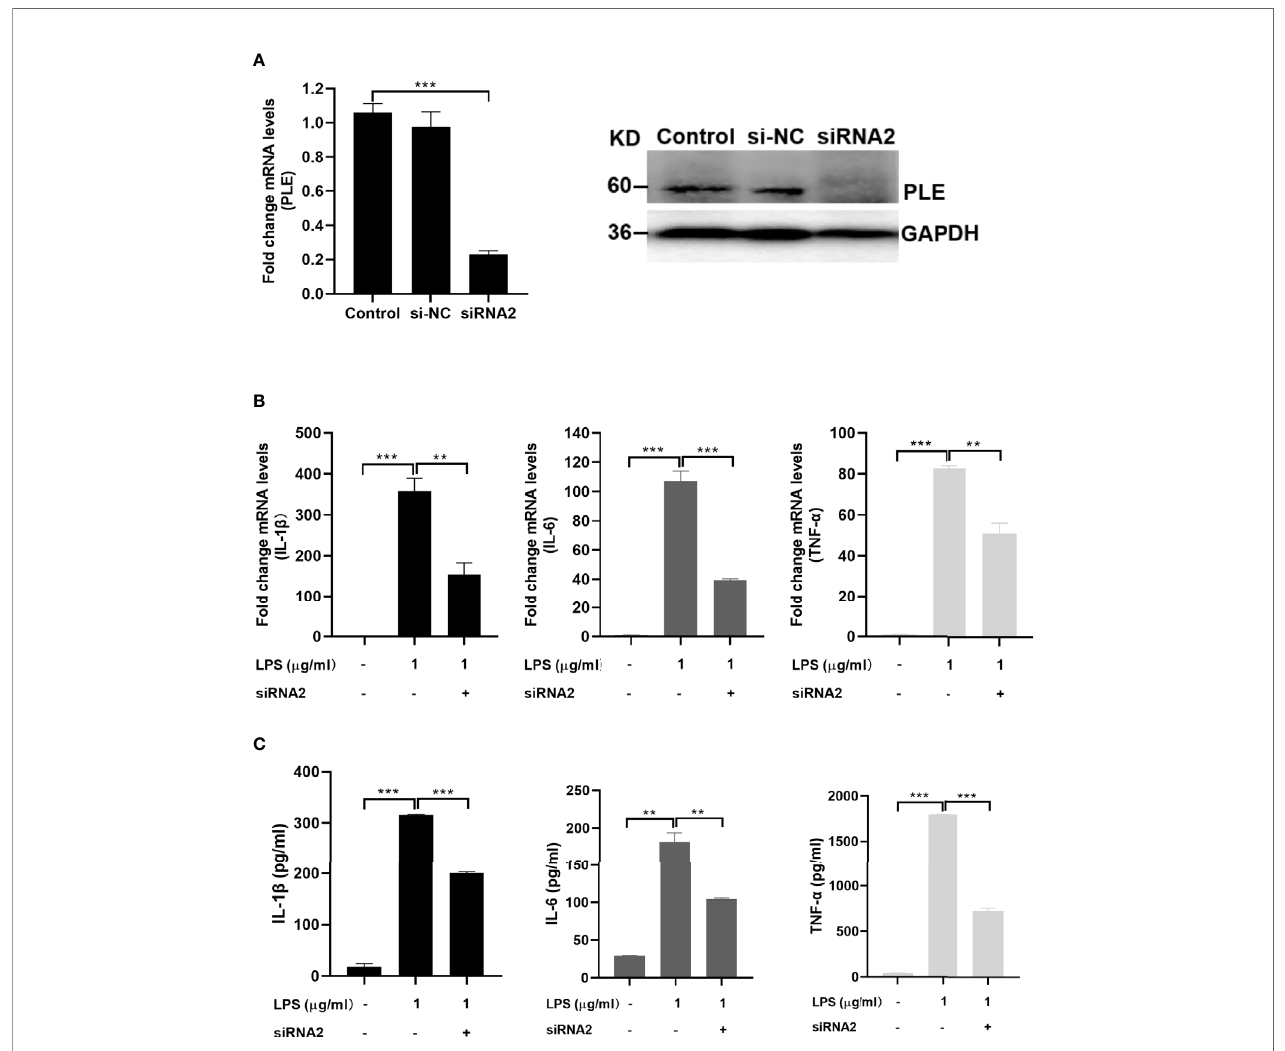
FIGURE 5 | Decreased LPS-stimulation on the expression of proin fl ammatory cytokines in PAMs by transfection of siRNA2 targeting PLEs. (A) The expression of PLEs was con fi rmed by RT-qPCR (left) and western blotting (Right). si-NC: si negative control. (B) Decreased LPS-stimulation on the mRNA expression of proin fl ammatory cytokines in PAMs by transfection of siRNA2 targeting PLEs. PAMs were cultured for 24 h, and then transfected with siRNA. After incubation for 24 h, LPS (1 µg/mL) was treated for additional 6 h Then, total RNA was isolated and analyzed for the mRNA level of proin fl ammatory cytokines by RT-qPCR. (C) Decreased LPS-stimulation on the protein expression of proin fl ammatory cytokines in PAMs by transfection of siRNA2 targeting PLEs. Cells were treated as Experiment B (above). However, culture supernatant was collected and analyzed by ELISA. Data are presented as the mean ± SEM of 3 independent experiments. Statistical signi fi cance was indicated by asterisks (** P < 0.01; *** P <